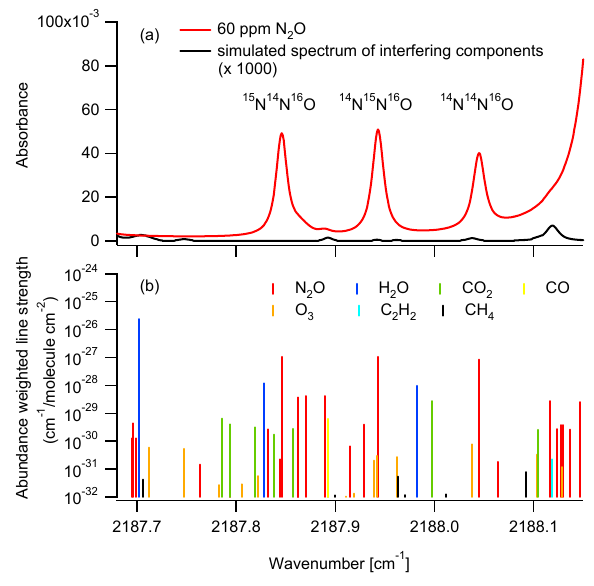
Fig. 5. (a) Simulated absorption spectra of N 2 O and spectroscop- ically interfering components after preconcentration of ambient air (magnified by a factor 1000). (b) Absorption lines of atmospheric constituents in the wavelength region selected for N 2 O isotopic